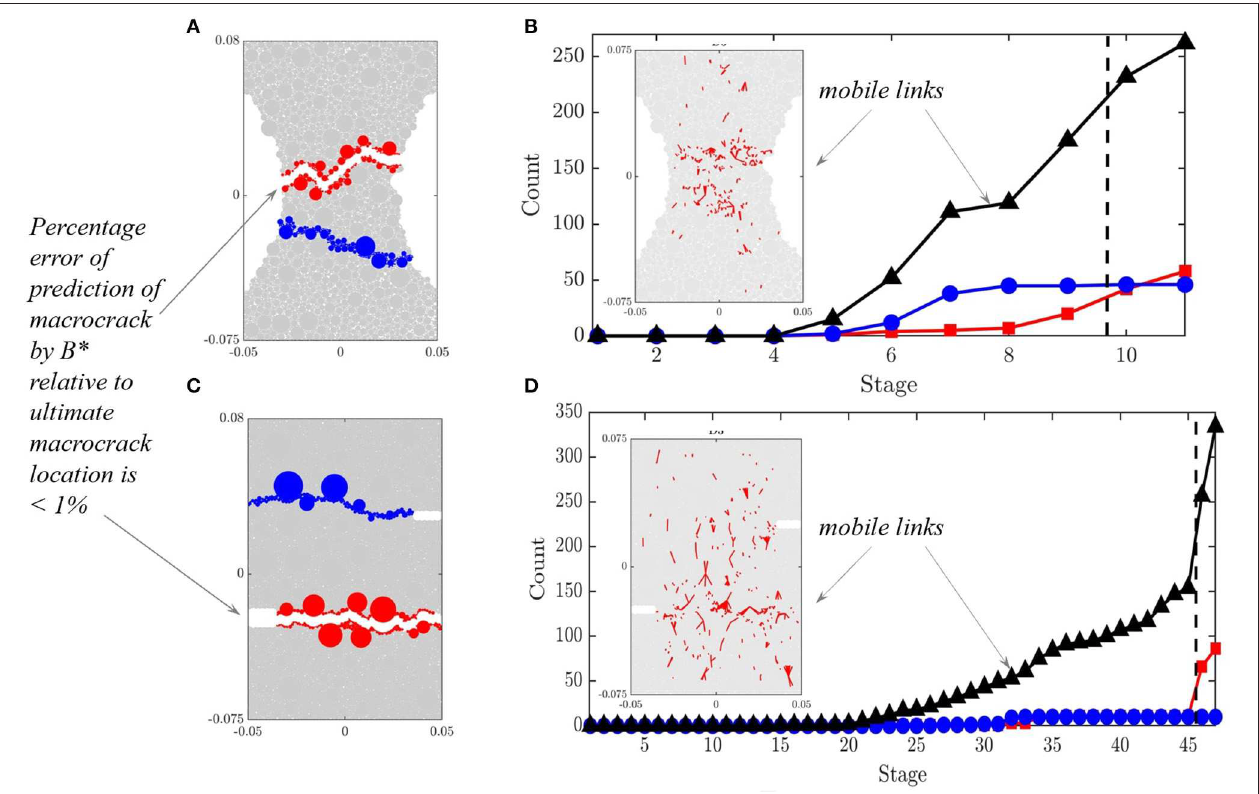
FIGURE 10 | (Color online) System-spanning preferential paths for damage. (A,B) DI and (C,D) DII. (A,C) Preferential paths for damage B . Grains on either side of the ultimate macrocrack location are artificially separated to aid visual comparison with the primary bottleneck B ∗ (red grains) and the secondary bottleneck (blue grains) (B,D) Evolution of the number of broken bonds in B ∗ (red), the secondary bottleneck (blue), and mobile links elsewhere (black) with their spatial distribution (inset). Dashed vertical line marks the stage at peak load.